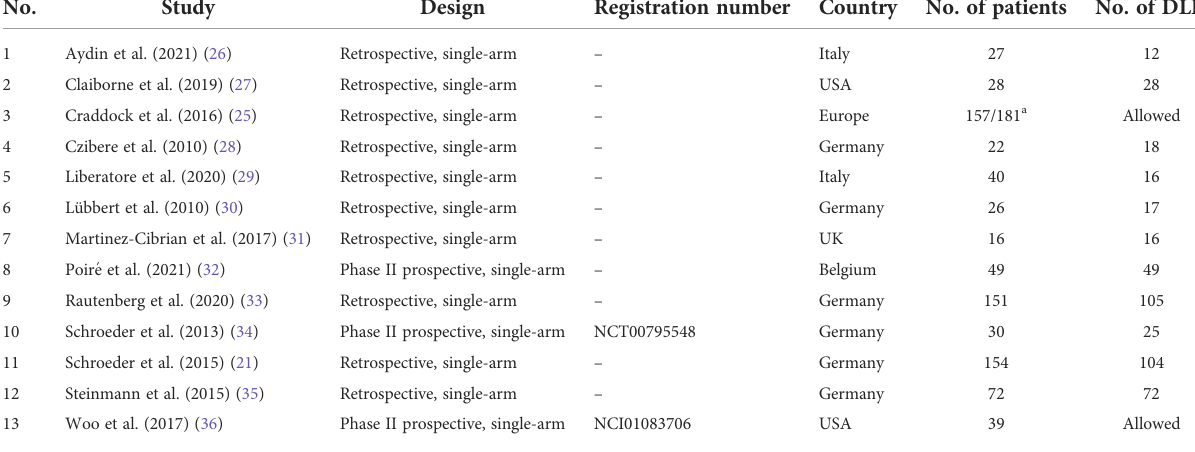
TABLE 1 Characteristics of the included